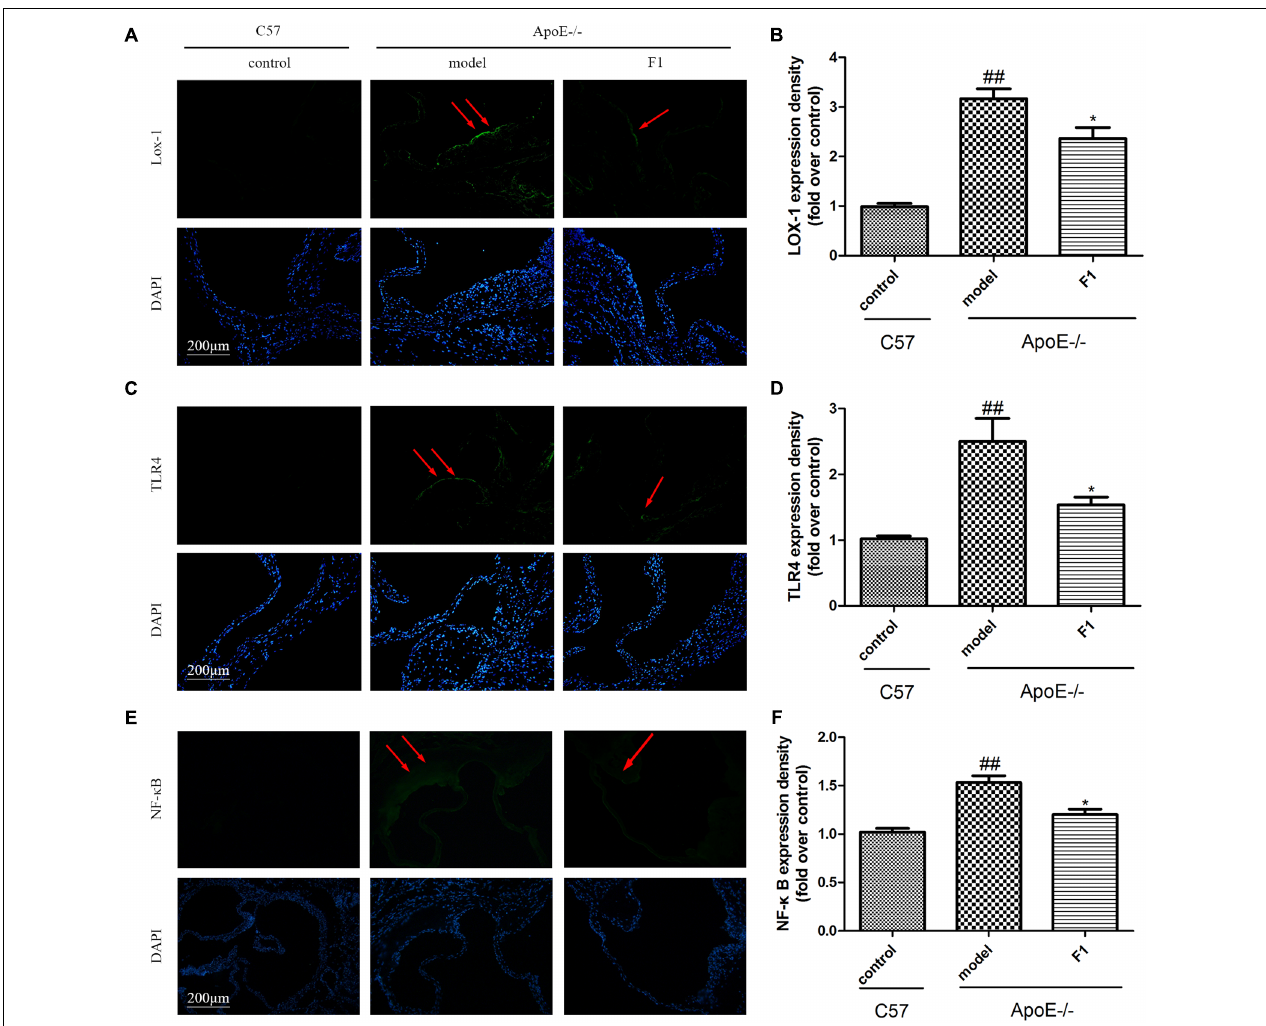
FIGURE 3 | Ginsenoside F1 decreased LOX-1 and TLR4 expression at the aortic valve in ApoE − / − mice. All mice were fed HFD. ApoE − / − mice were treated with GF1 (50 mg/kg/day, i.g.), probucol (2 mg/kg/day, i.g.), or its vehicle (as model group) for 8 weeks; C57 mice were used as the control group. (A) Representative images of LOX-1 expression under immunofluorescent staining. (B) Quantitative analysis of LOX-1 expression in aortic valve. (C) Representative images of TLR4 expression under immunofluorescent staining. (D) Quantitative analysis of TLR4 expression in aortic valve. (E) Representative images of NF- κ B expression under immunofluorescent staining. (F) Quantitative analysis of NF- κ B expression in aortic valve. Values ( n = 10 per group) are expressed as the mean ± SD. ## p < 0.01, vs. C57 control group; ∗ p < 0.05 vs. the vehicle-treated ApoE − / − model